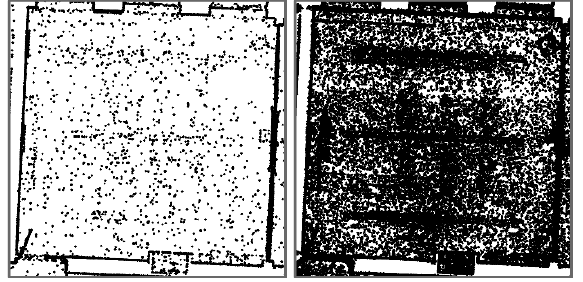
Figure 2 : Point cloud thinned to 1 point in 500 (left) of original density (right) emphasizes walls, doors, windows while greatly improving rendering speed.